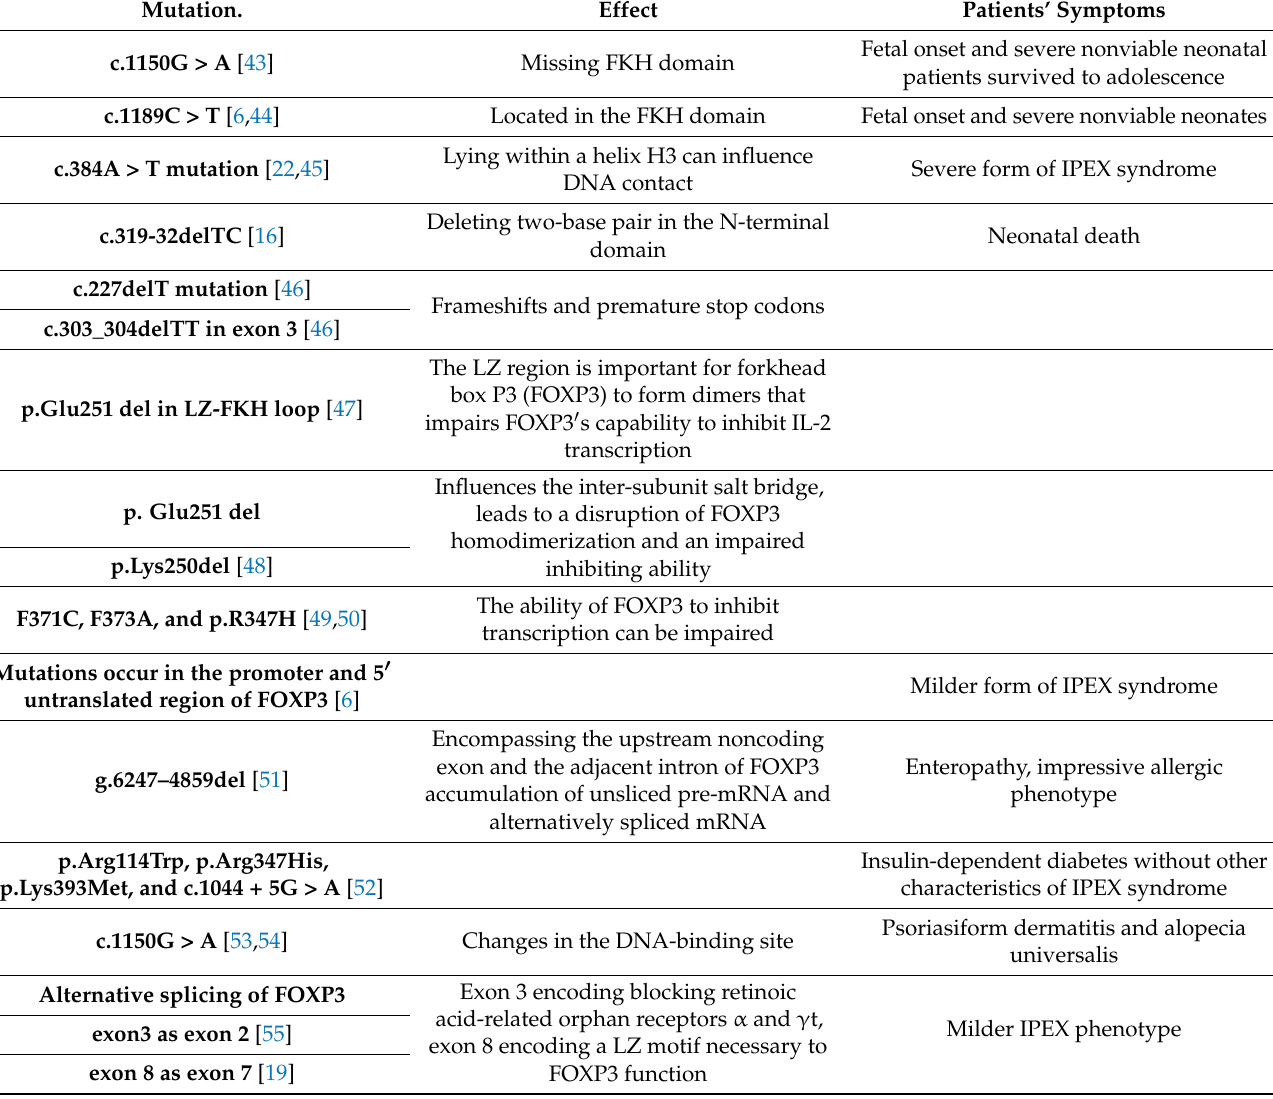
Table 1. The connection between the mutations and clinical symptoms in immune dysregulation, polyendocrinopathy, enteropathy, X-linked (IPEX)